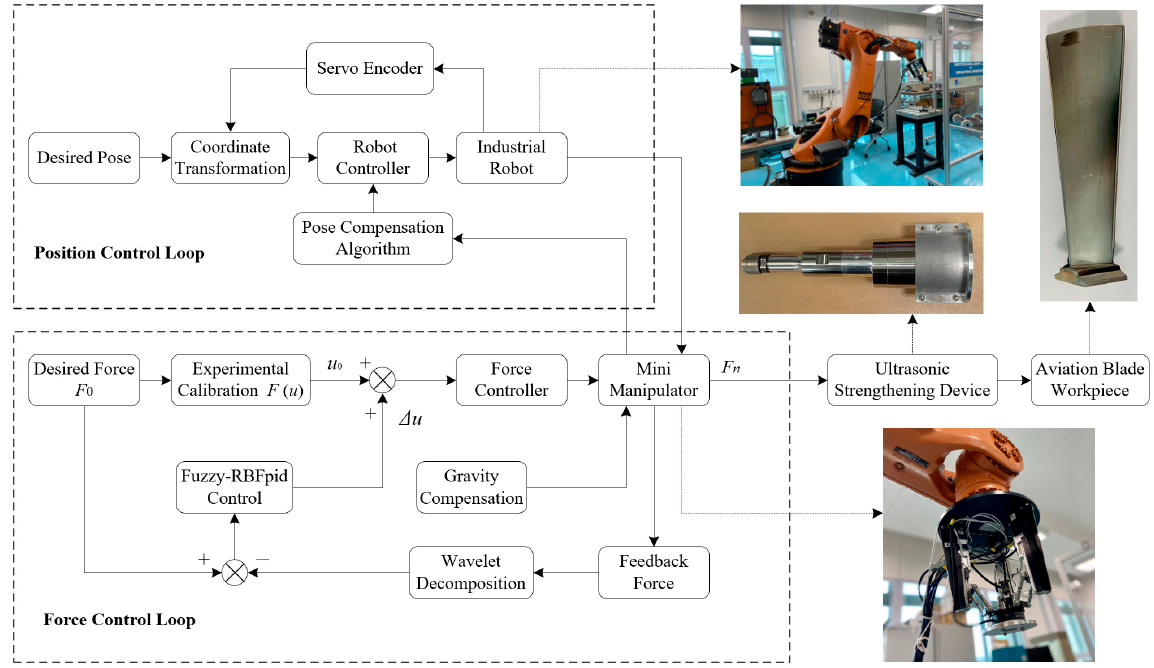
Figure 1. Force/position control schematic of robotic ultrasonic surface strengthening.